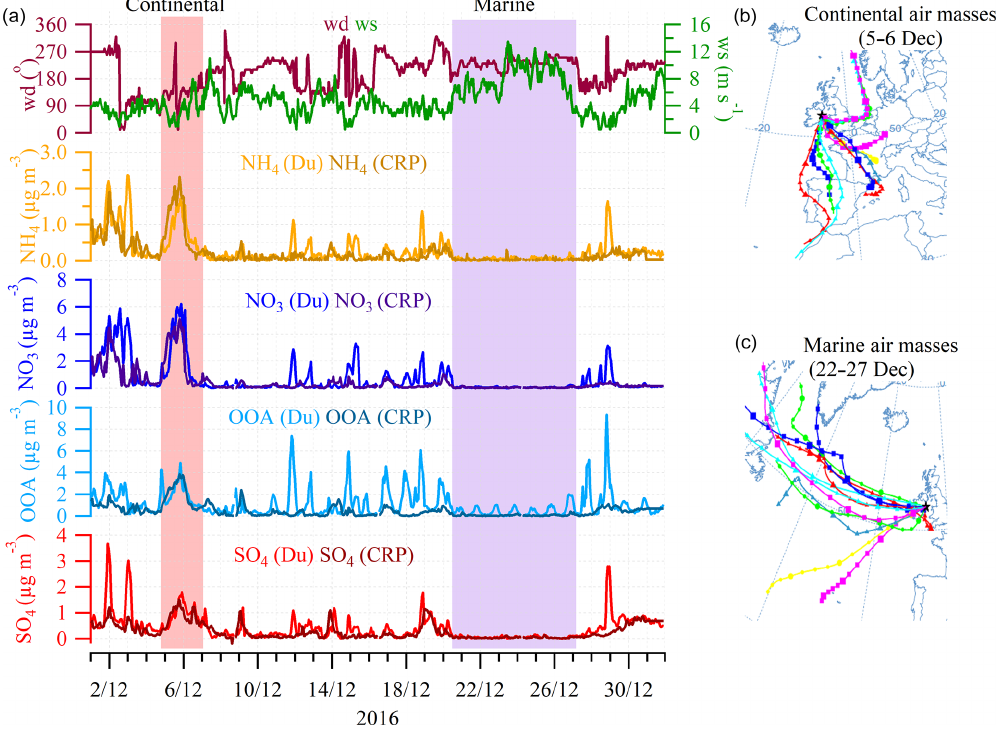
Figure 5. Comparison of the time series of sulfate (SO 4 ), nitrate (NO 3 ), ammonium (NH 4 ), and oxygenated organic aerosol (OOA) at the urban site in Dublin (Du) and the rural site in Carnsore Point (CRP). The light red highlighted periods on 5–6 December 2016 were continental air mass periods, while the light blue highlighted periods on 22–27 December 2016 were marine air mass periods. The back trajectories (BTs) in (b) and (c) were calculated using the Hybrid Single-Particle Lagrangian Integrated Trajectory (HYSPLIT; Stein et al., 2015). The BTs were calculated for an arrival height of 500m at the length of 72h. BTs were calculated every 6h for continental air masses during 5–6 December (b) and every 12h for marine air masses during 22–27 December (c)